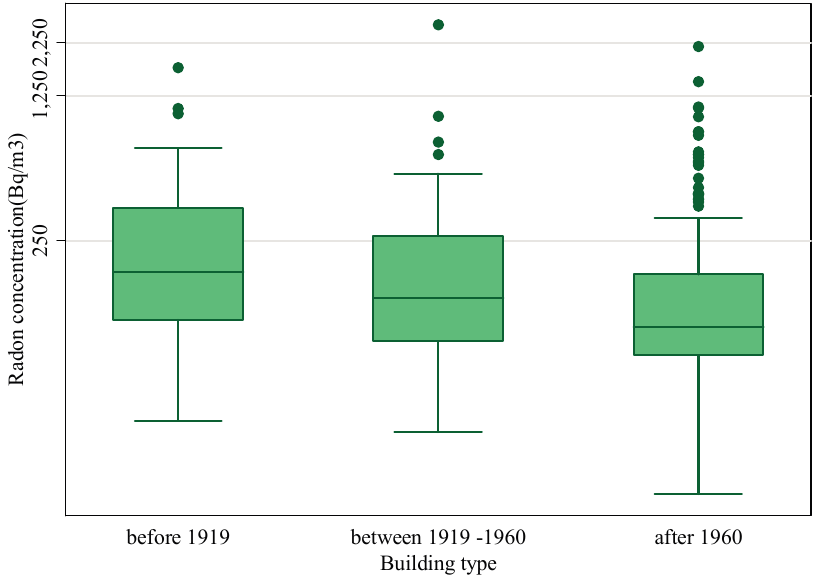
Figure 5. Relationship between radon concentrations and building age.